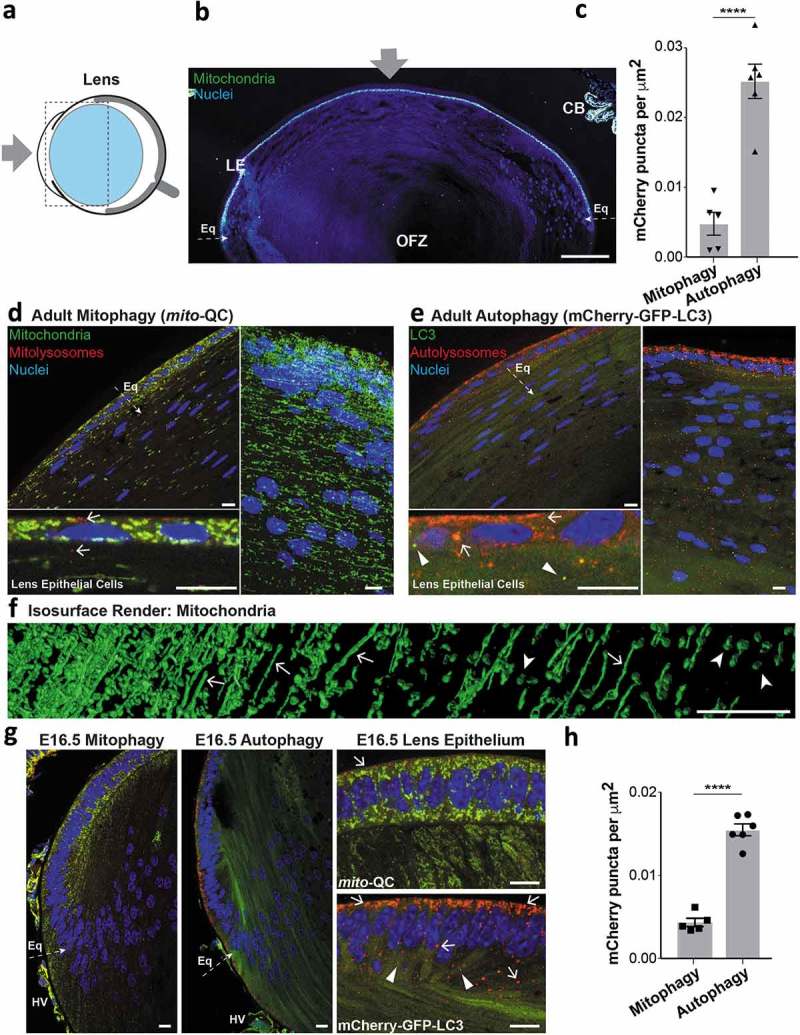
Mitochondrial architecture, mitophagy and autophagy in the adult lens. (a) Schematic of the mouse eye depicting anatomical location of the lens in light blue. Boxed area is shown in panel (b) and gray arrow represents light path. (b) Overview photomicrograph of mito-QC eye section depicting the lens; LE, lens epithelium; Eq, equatorial region; OFZ, organelle-free zone; CB, ciliary body. Gray arrow, as in panel A. Scale bar: 100 μm. (c) Quantification of mCherry-only puncta from mito-QC (mitophagy) or mCherry-GFP-LC3 (autophagy) lens sections. Data points represent means from individual animals ±SEM (***P < 0.0001). (d) Upper left panel shows optical section of the adult lens equatorial region from a mito-QC mouse, below is magnified area of lens epithelium showing small spherical mitochondria and minimal mitophagy, with examples of mitolysosomes marked by arrows. Panel on right shows maximum Z-projection of lens optical slices. (e) Upper left panel shows optical section of the adult lens equatorial region from a mCherry-GFP-LC3 mouse, below is magnified area of lens epithelium with examples of autolysosomes marked by arrows and autophagosomes by arrowheads. Panel on right shows Z-projection of lens optical slices. (f) Isosurface render detailing mitochondrial network in mito-QC with lens epithelium on the left side of the panel (lateral to medial = left to right). Arrows denote examples of elongated mitochondria and arrowheads that of smaller solitary mitochondria. (g) Optical sections from E16.5 eyes detailing equatorial region (Eq), hyaloid vessels (HV) are also marked. Magnified epithelium sections are shown on the right, with arrows showing examples of mitolysosomes (top panel) and autolysosomes (bottom panel). Arrowheads mark autophagosomes. (h) Quantification of mCherry-only puncta from mito-QC (mitophagy) or mCherry-GFP-LC3 (autophagy) E16.5 lens sections. Data points represent means from individual animals ±SEM (***P < 0.0001). Scale bars (panels D-G): 10 μm.